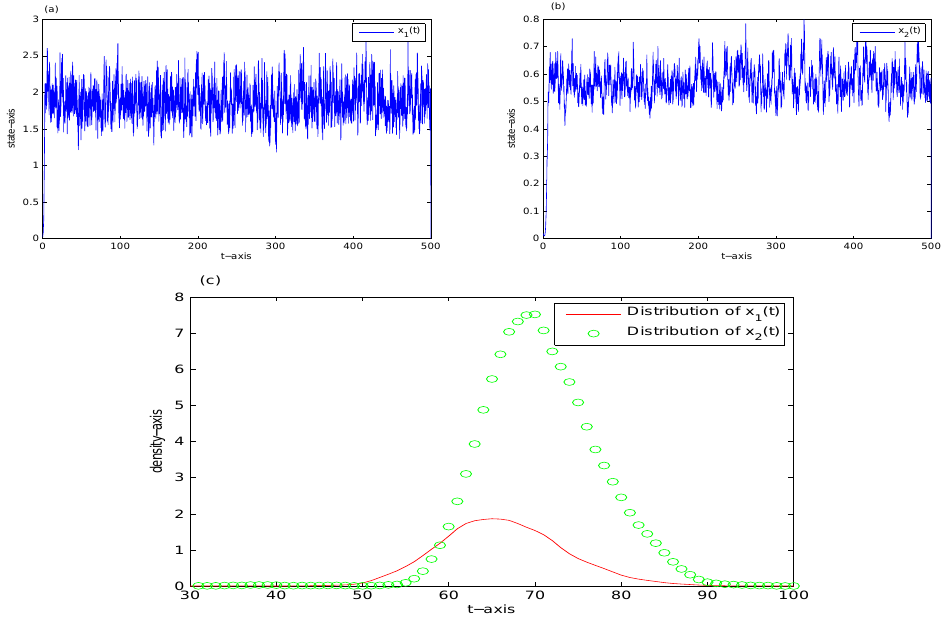
Figure 4. The distribution of (13) with initial data x 1 ( 0 ) = x 2 ( 0 ) = 0.02. ( a ) the time series graph of x 1 ( t ) ; ( b ) the time series graph of x 2 ( t ) ; ( c ) the density of distribution of x 1 ( t ) and x 2 ( t )